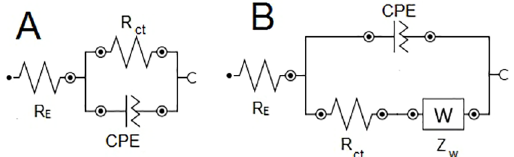
Figure 6. Equivalent circuits used to simulate the EIS data obtained for the coatings produced using Solution 2: (A) Experiments 1 and 3; (B) Experiment